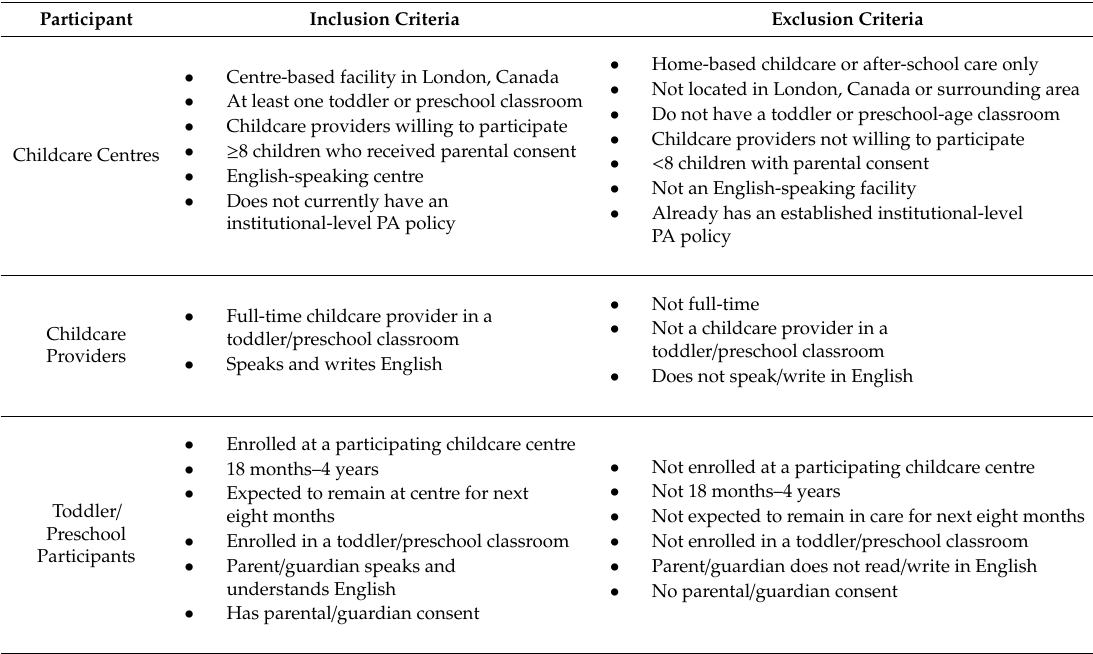
Table 1. Inclusion and exclusion criteria for the Childcare PLAY Policy